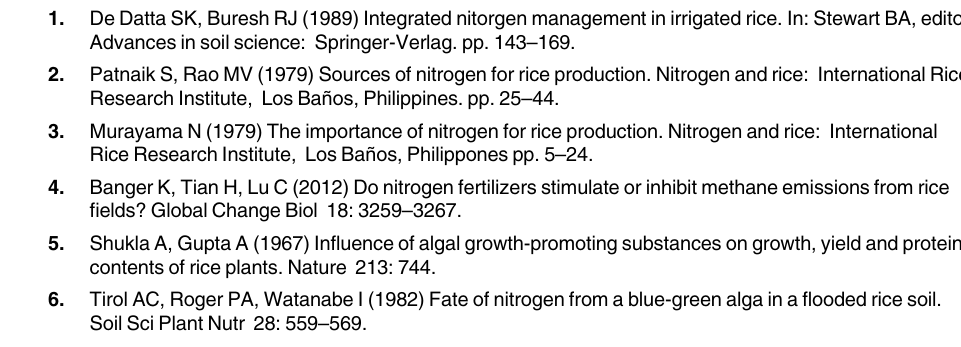
S1 Table. Linear regression models for microalgal growth by optical density (OD). (DOCX) S2 Table. Linear regression models for microalgal growth by dry weight. (DOCX) S3 Table. Analysis of variance of rice seedling growth after the microalgal treatments.